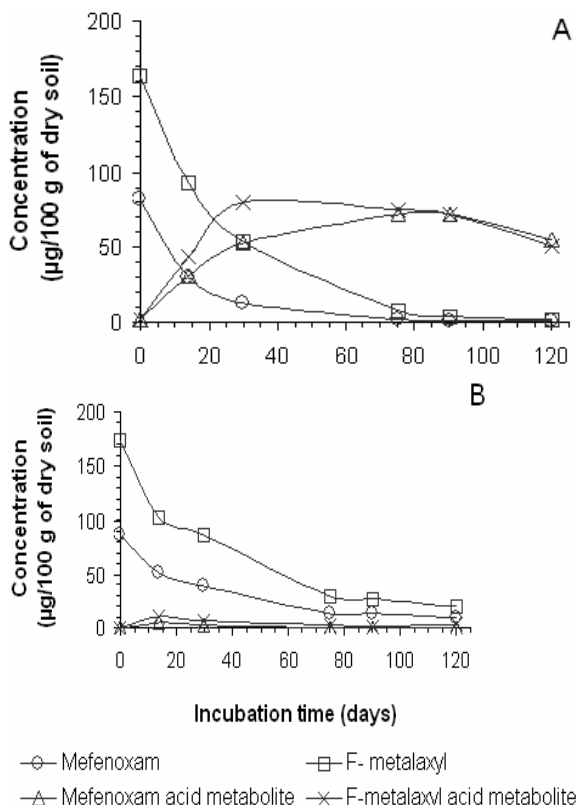
Figure 5: Profiles of Mefenoxam and F- metalaxyl fungicides degradation in A) German soil and B) Cameroonian soil. Note the concurrent formation and degradation of the respective acid metabolite resulting from Mefenoxam and F- metalaxyl. Concentrations plotted versus incubation time (days).